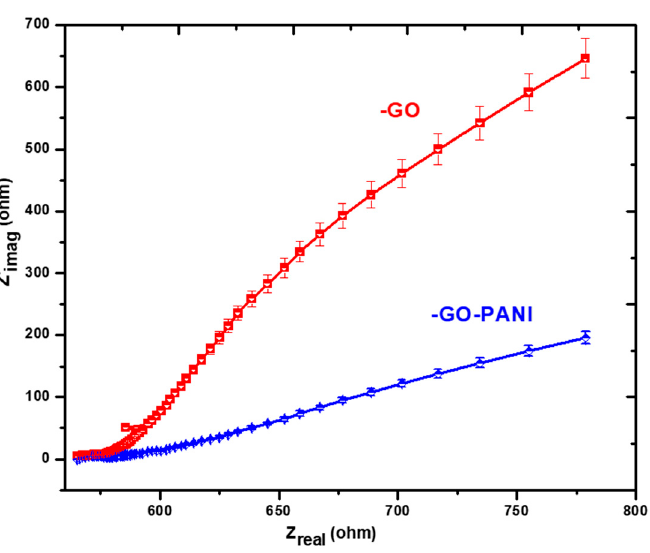
Figure 9. Nyquist-electrochemical impedance spectroscopy (EIS) analysis of the fabricated anode.